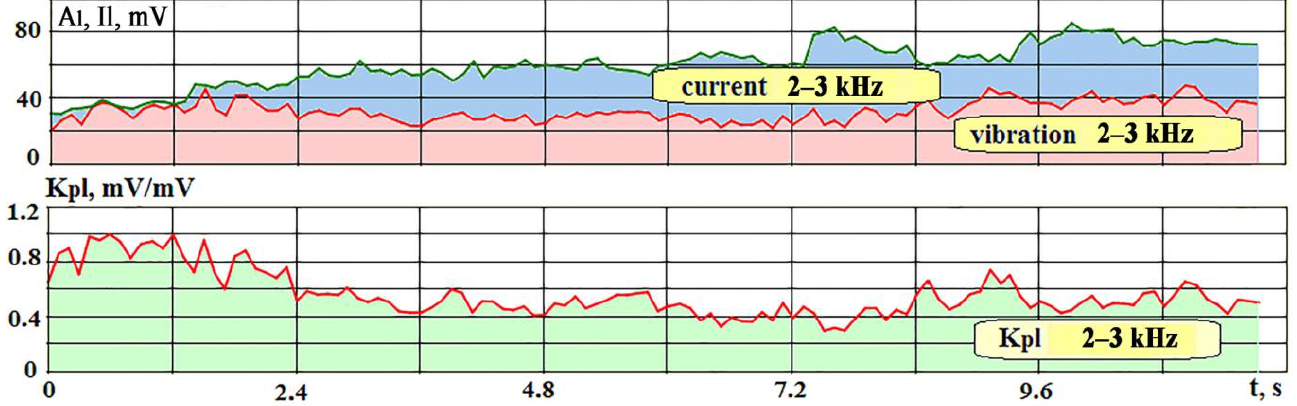
Figure 9. The procedure for constructing the transmission coefficient at low frequencies (upper graph) and its change (lower graph) from the moment of embedding to the break of the wire electrode: A l — RMS amplitude in the low-frequency range; Il — RMS amplitude of the discharge current; Kpl — transmission coefficient in the low-frequency range.